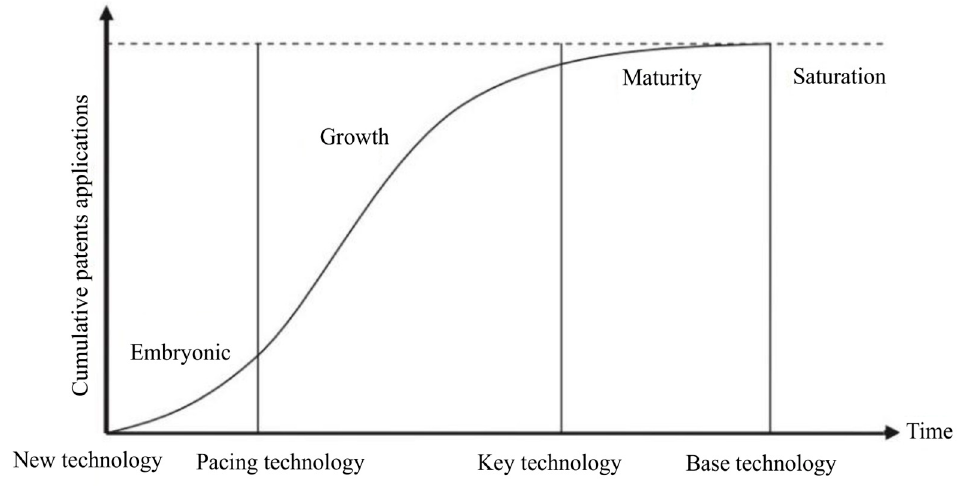
Figure 7. Typical S-curve of the life cycle of technologies. Source: Adapted from Taylor and Taylor [39].